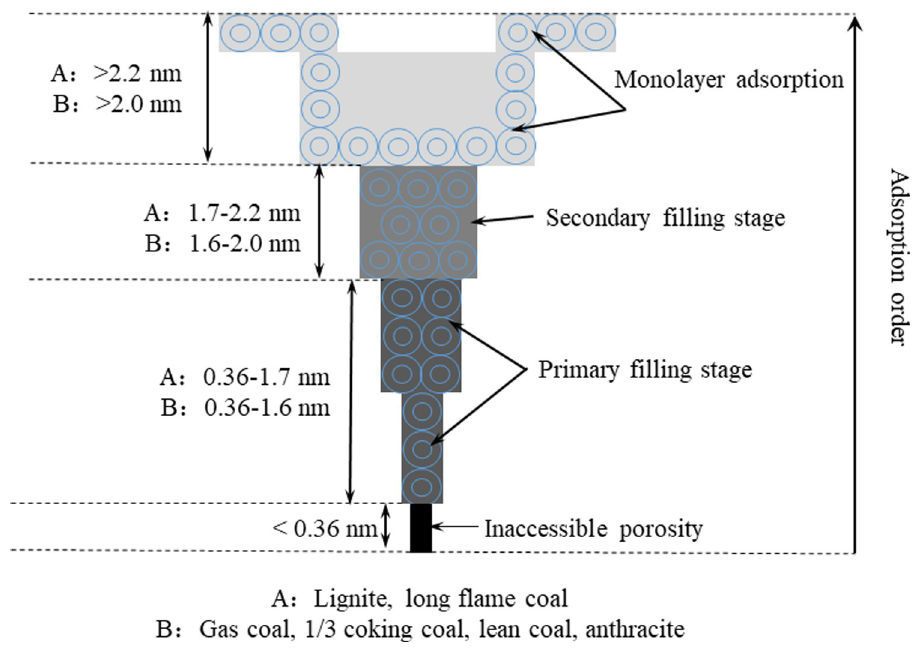
Fig 7. Main stages in the continuous filling of micropores during the adsorption